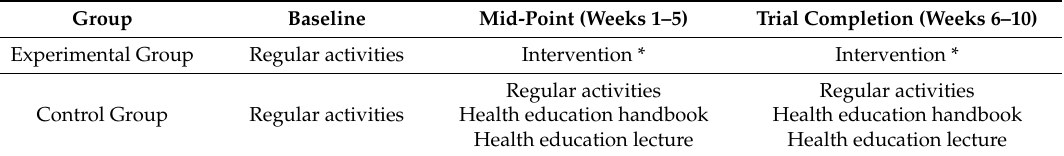
Table 4. Experimental